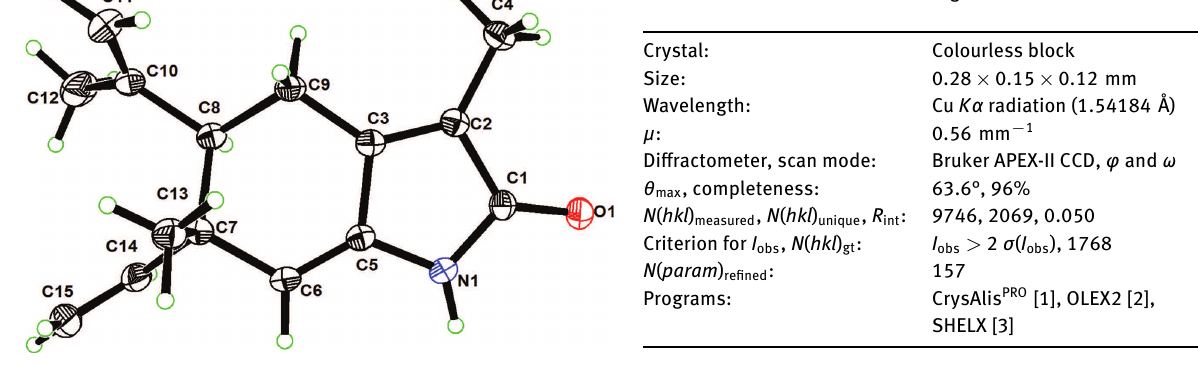
Table 1: Data collection and handling.